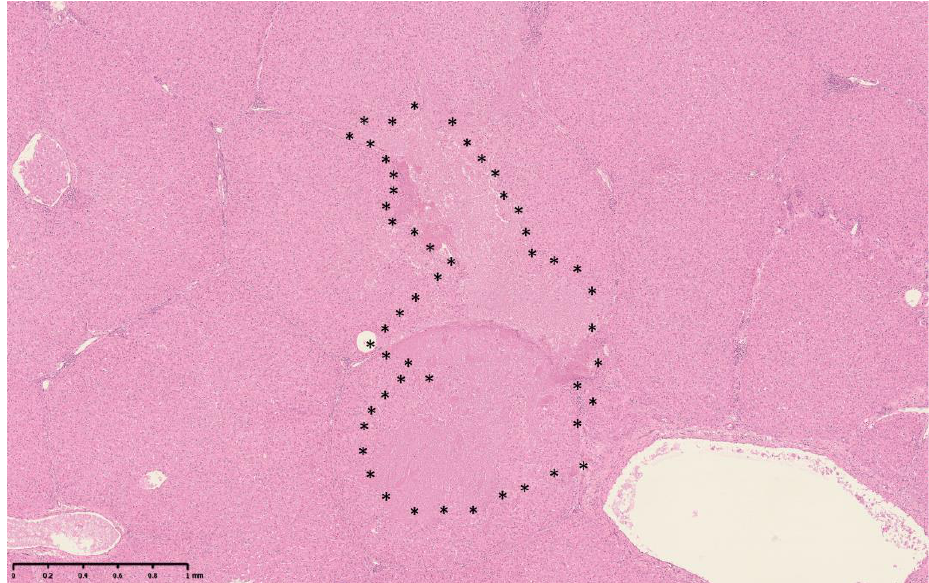
Figure 3. An example of a well-demarcated BH lesional site, measuring at 2.34 mm by 1.19 mm in this plane of section (scale bar shown), delineated by asterisks, and composed of type A and type B lesions, with minimal formation of cavities. The lesional site spreads over adjacent lobules and is not demarcated by interlobular septa (H&E). The cellular contents appear not to be fully aspirated at the time of procedure.